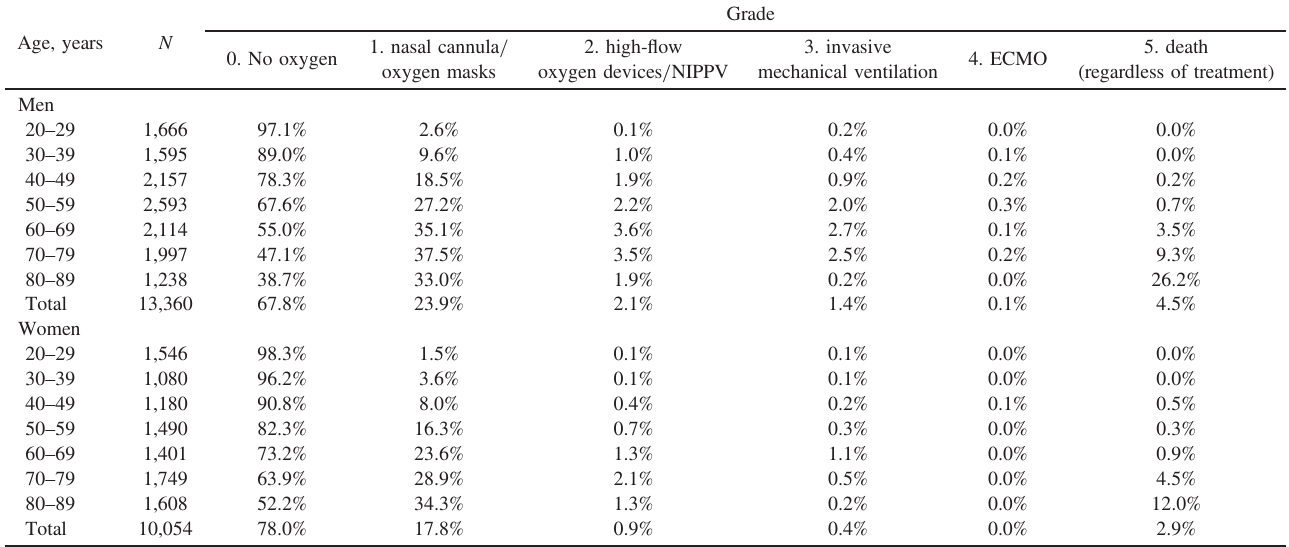
Table 1. De fi nition of grade according to the most intensive treatment or death and the frequency of each severity grade by sex and age groups among 23,414 COVID-19 patients registered in Japan Age,